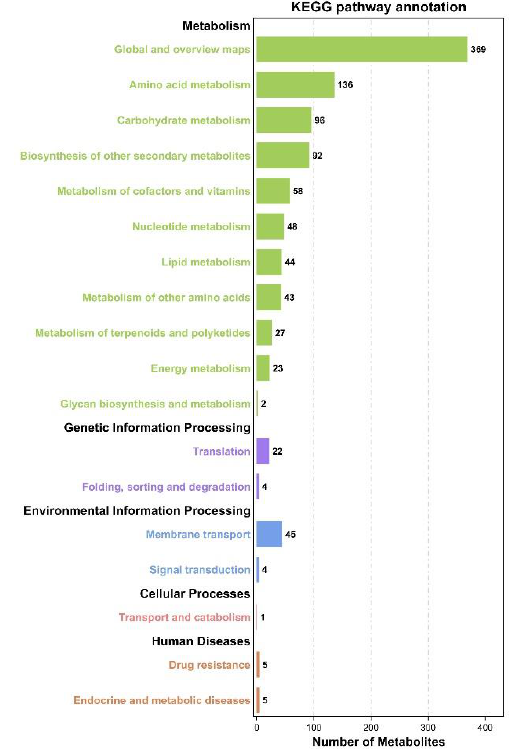
Agronomy 2022 , 12 , x FOR PEER REVIEW Figure 7. The statistical figure in the KEGG for all metabolites. Figure 7. The statistical figure in the KEGG for all metabolites.